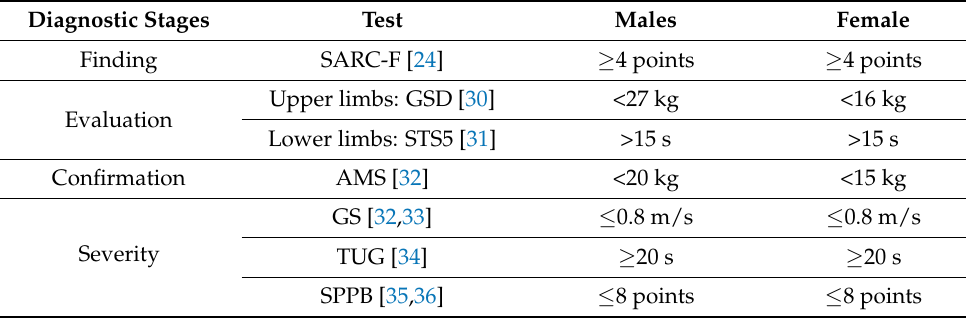
Table 1. Cut-off points for diagnosis of sarcopenia according to